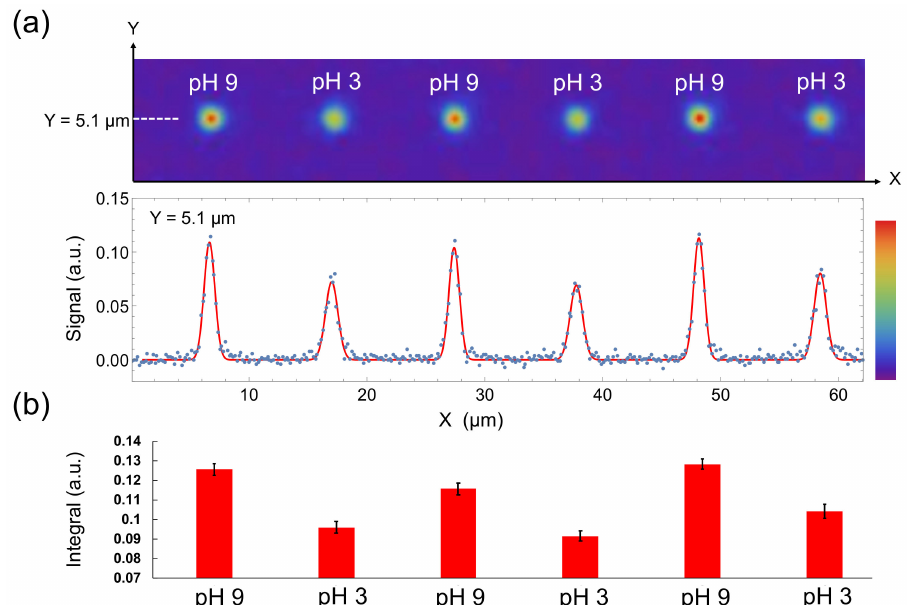
Figure 5. ( a ) T 1 -weighted images of a 100-nm nanodiamond in alternately changing pH conditions (top) and its signal intensity in Y = 5.1 µ m plotted against X (bottom). Red line represents the fitting function, which contains six gaussian functions. ( b ) Definite integrals of the fitted gaussian functions. Error bars represent the standard error of the gaussian fitting.